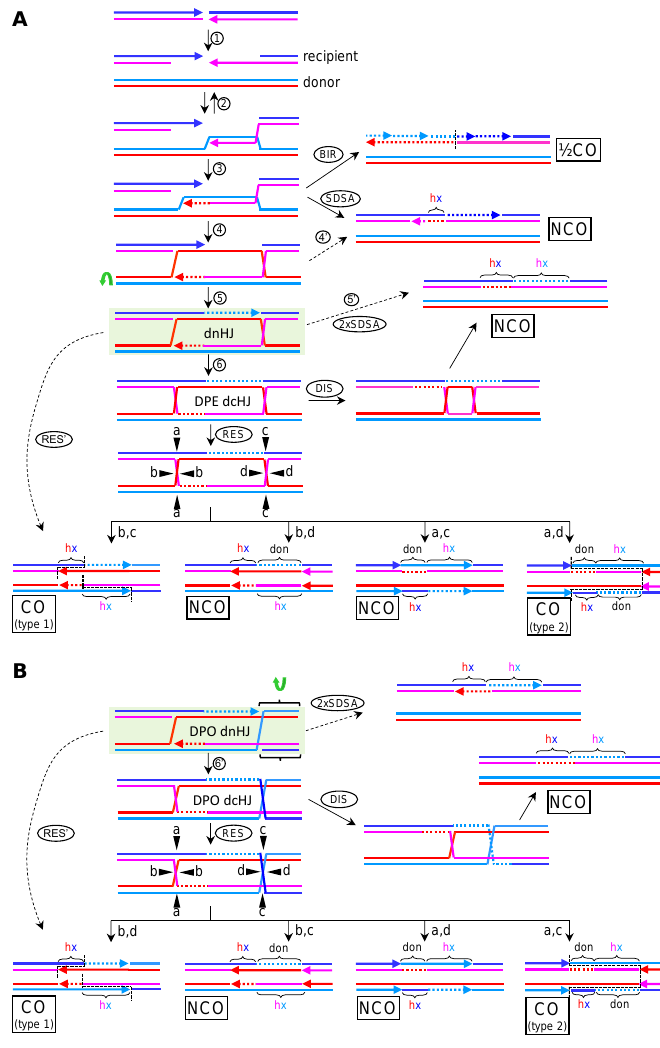
Figure 7. HR pathways for DSB repair. ( A ) Canonical model with DSBR through DPE dHJs. Steps: (1) Resection of DSB 5 (cid:48) ends; (2) one 3 (cid:48) overhang invades a donor homologous sequence to form a reversible D-loop; (3) the D-loop primes de novo DNA synthesis (red dotted line); (4) the second DSB end is captured by the displaced strand; (5) the second capture also primes de novo DNA synthesis (cyan dotted line), and when synthesis from both ends cover the resected tracts, a dnHJ is formed; (6) ligation of the nicks results in a DPE dcHJ; (DIS) dissolution of the dcHJ by RTR results in NCOs with two-sided heteroduplex DNA in the recipient molecule; (RES) resolution by SSEs can result in four different products, two NCOs and two COs, with different local genetic patterns (see main text for further details). Deviations from the DSBR model: (BIR) DNA synthesis from the D-loop continues until the end of the chromosome, lagging-type synthesis makes the complementary strand; (SDSA and 4 (cid:48) ) the D-loop is dismantled after some DNA synthesis, the extended strand reanneals with its parental complementary strand and further DNA synthesis fills in the ssDNA gaps; (2xSDSA / 5 (cid:48) ) the dnHJ is disassembled and strands reanneal with their parental counterparts; (RES’) SSEs cut the dnHJ resulting in just a single resolution product (type 1 CO). ( B ) The alternative DSBR model with DPO dHJs. This model includes the cross-join isomerization expected for the second nHJ, resulting in a DPO dnHJ; (6 (cid:48) ) ligation would yield a DPO dcHJ. From a genetic point of view, the products of SSE resolution (RES and RES’), RTR dissolution (DIS), and dnHJ disassembly (2xSDSA) are identical to those of DPE dHJs. Other subpathway abbreviations: BIR, break-induced replication; SDSA, synthesis dependent strand annealing. Abbreviations for global genetic products: NCO, non-crossovers; CO, crossovers; 1 CO, half crossovers. Abbreviations for local genetic rearrangements: hx, heteroduplex 2 DNA tract (delimited by brackets; the color of each letter encodes the strands involved in the heteroduplex); don, donor sequence tract. The green arched arrow indicates a visual flipping of DNA molecules, or part of them (brackets indicate the flipping portion). The black arrowheads and attached lower case letters point to the nicking planes during resolution. For other abbreviations and signs see previous figure